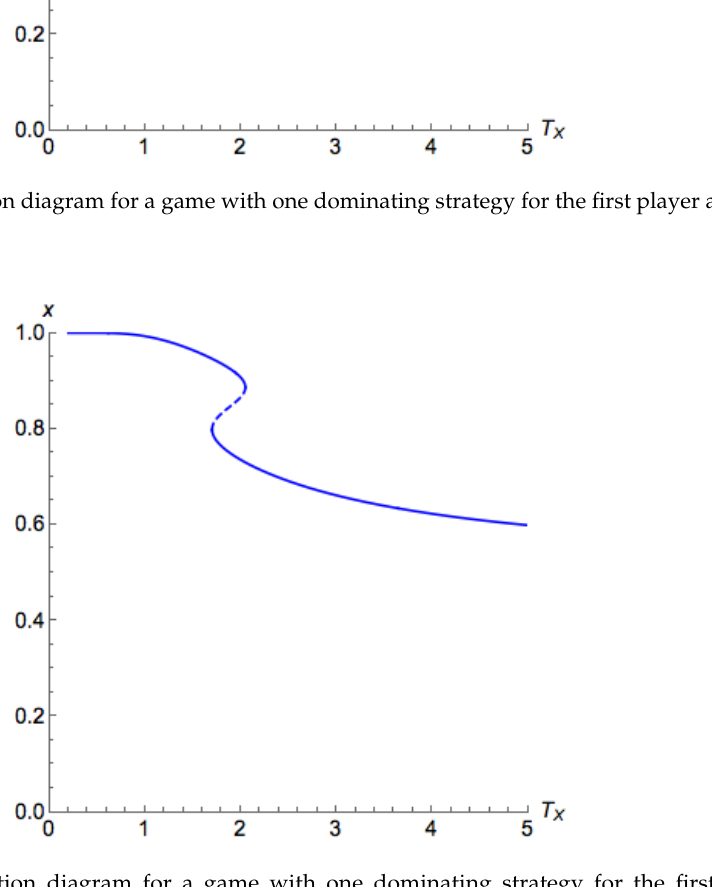
Figure A4. Bifurcation diagram for a game with one dominating strategy for the first player, a Y + b Y > 0, and a Y < b Y